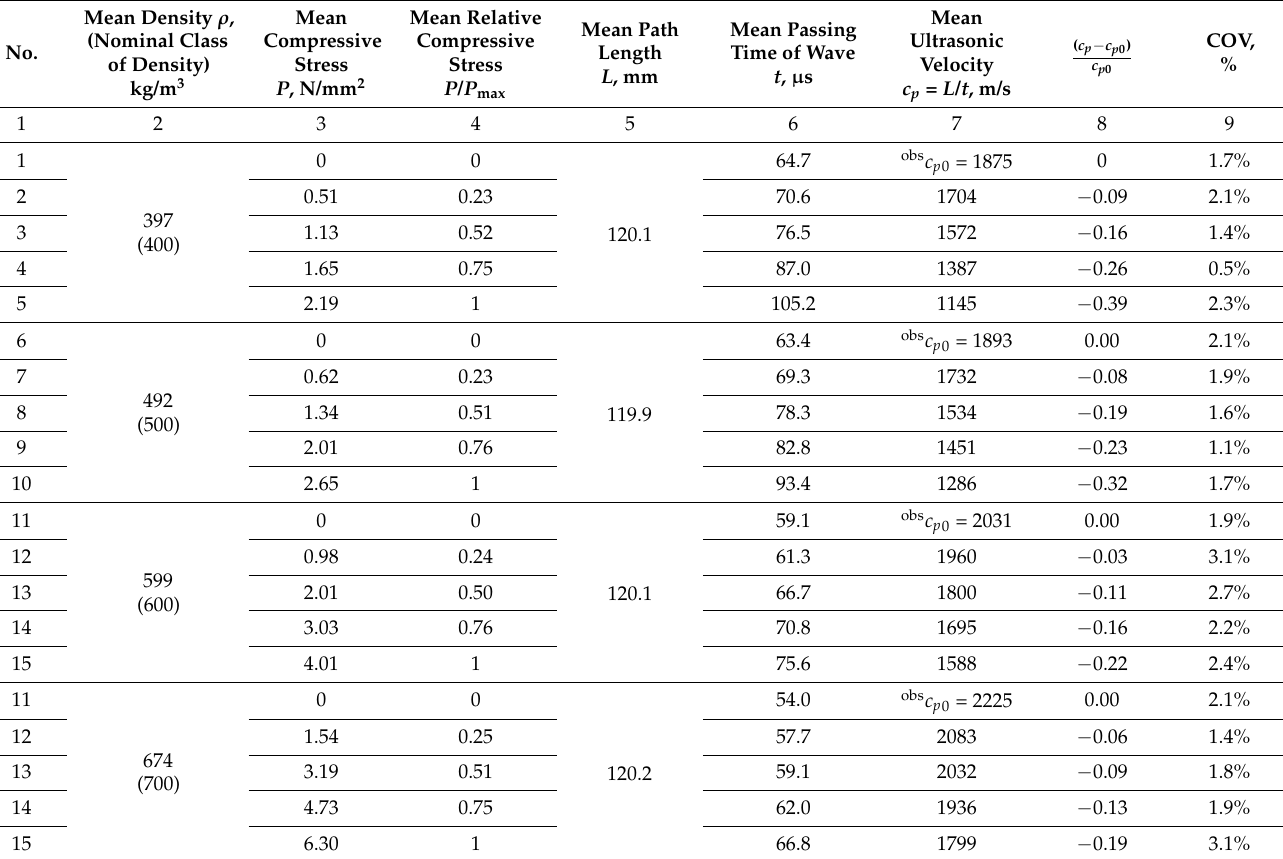
Table 2. Test results for ultrasonic wave velocity in AAC under various mean hydrostatic stresses determined at central points (B1–B3, C1–C3, D1–D3, E1–E3) of each